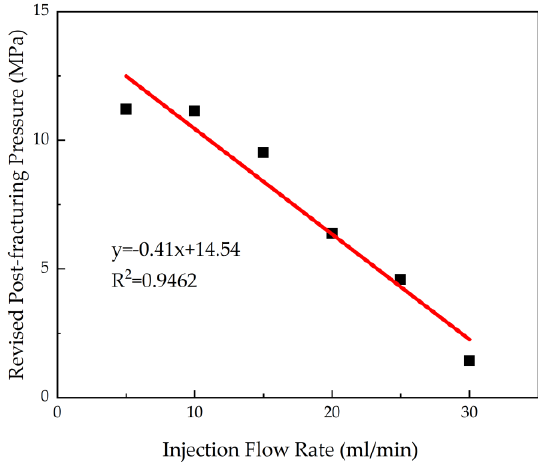
Figure 11. Influence of injection flow rate on the revised post-fracturing pressure.